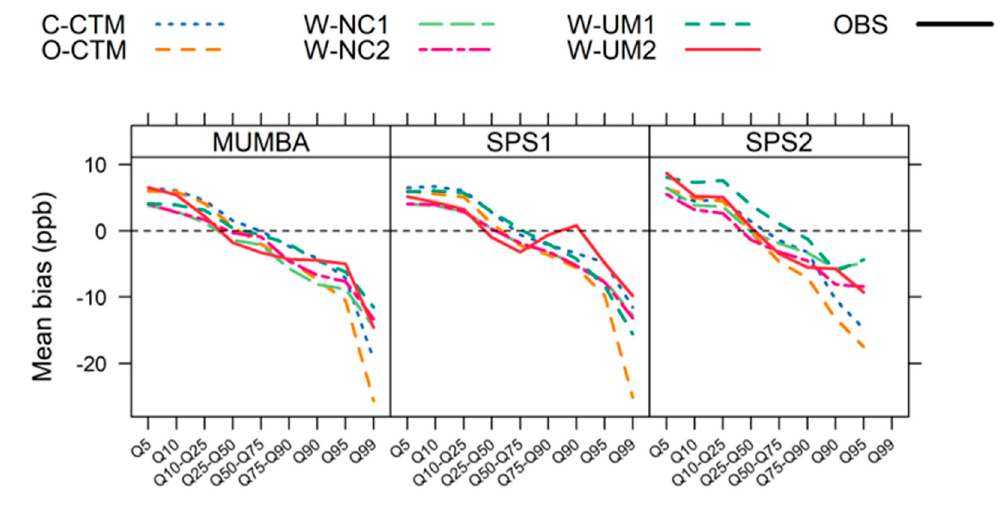
Figure 4. Mean bias for paired model / observed O 3 values, split into quantile bins (0–1, 1–5, 5–10, 10–25, 25–50, 50–75, 75–90, 90–95, 95–99 and 99–100 percentiles) for observed values.